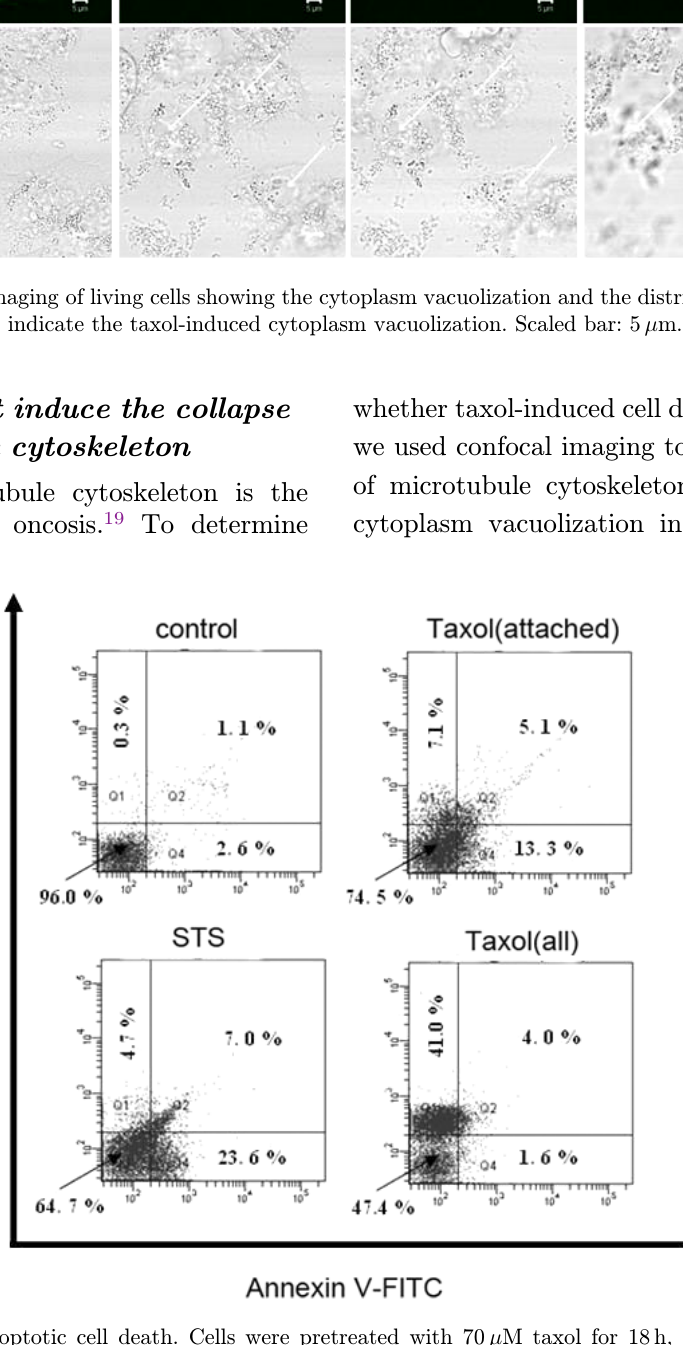
Fig. 3. Taxol-induced nonapoptotic cell death. Cells were pretreated with 70 (cid:1) M taxol for 18 h, and then were treated with Annexin V/PI double staining method for apoptosis detection. Taxol ( attached ), attached cells after taxol treatment; Taxol ( all ), attached and suspended cells after taxol